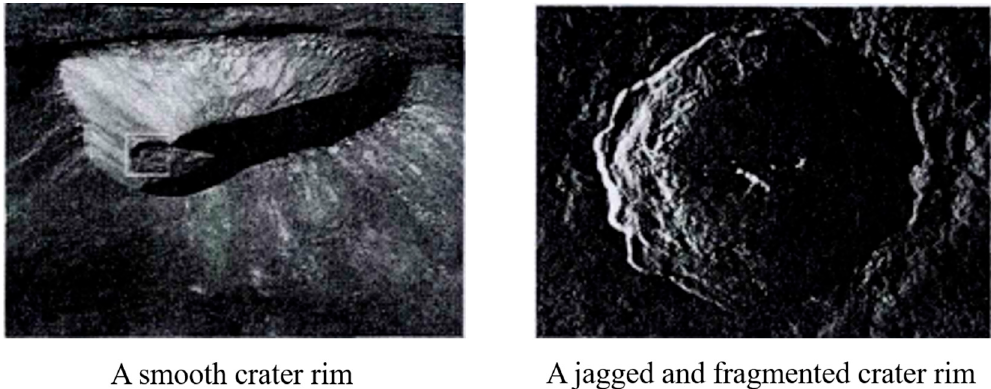
Figure 3. Crater rim shapes (from NASA, [52]).